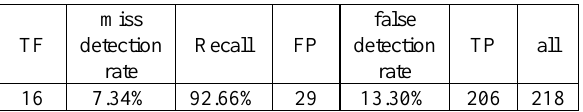
Figure 7. Results of airplane detection